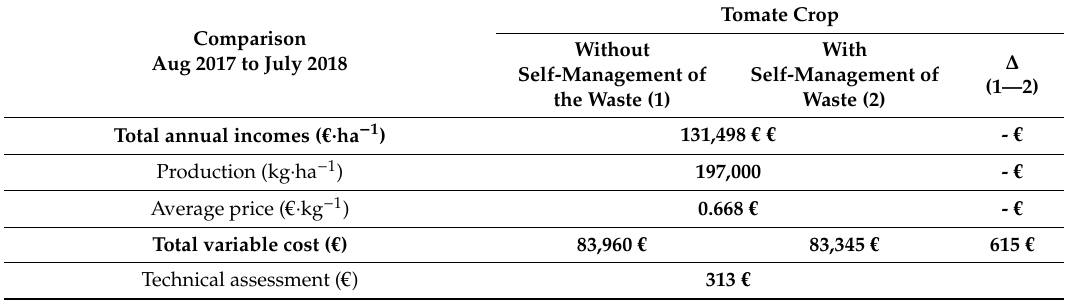
Table 2. Annual income statement for tomato crop. Impact of self-management of agricultural